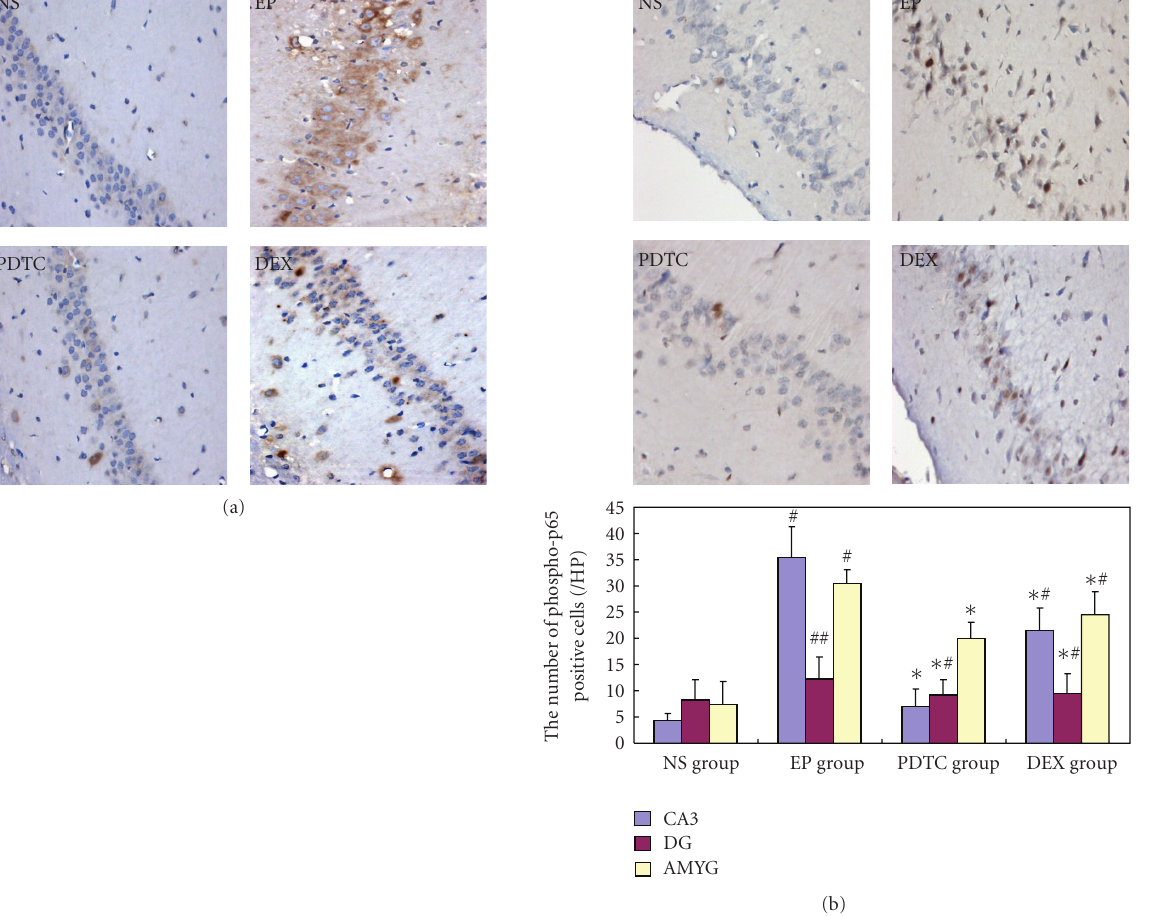
Figure 3: Pretreatment of PDTC, but not DEX, decreases KA induced NF- κ B activation. (a) Representative photos of immunohistochemistry staining with anti- NF- κ B p65 antibody ( × 400). NF- κ B expression and distribution pattern was detected in the rat brains of each group 24h after KA or vehicle micro-injection. The NF- κ B p65 immunoreactive cell number increased as well as more nuclear staining was observed in the EP group (EP) compared to the control rat (NS). By contrast with EP group, the number of NF- κ B p65 positive cells were decreased in the group pre-treated with PDTC (PDTC), but not in the group with DEX pretreatment (DEX). (b) Representative photos of immunohistochemistry staining with antiphospho-NF- κ B p65 antibody ( × 400). Activated NF- κ B in the rat brains of each group was detected 24h after KA or vehicle micro-injection. The number of Phospho-p65 positive cells significantly increased 24h after KA injection (EP) compared with that in NS group. Compared to the EP group, activated NF- κ B signal was significantly decreased in hippocampus CA3 area and amygdaloid nuclear complex of the rats pre-treated with PDTC (PDTC), but not in the rats with DEX pretreatment (DEX). # P < . 05 versus NS group; ## P > . 05 versus NS group; ∗ P < . 05 versus EP group; ∗ # P > . 05 versus EP group CA3, hippocampus CA3 area; DG: dentate gyrus; AMYG: amygdaloid